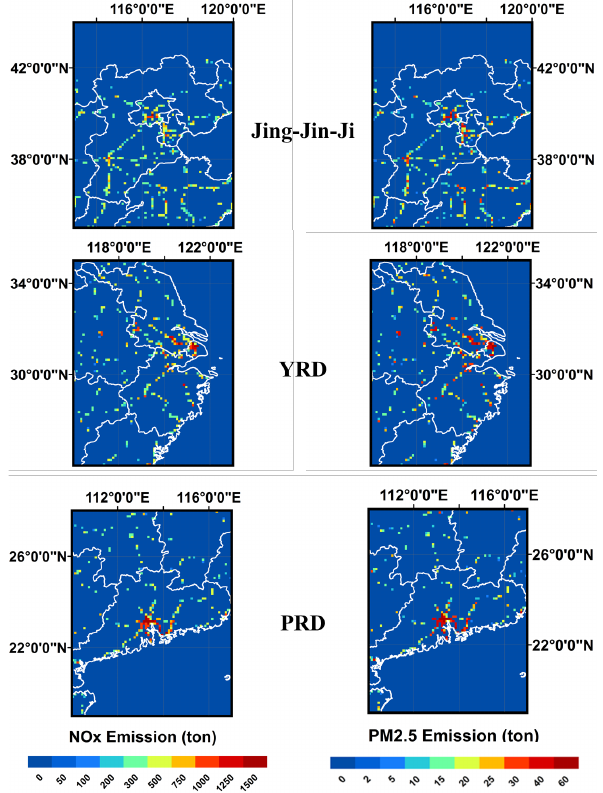
Figure 9. Maps of NO x and PM 2 . 5 emissions from freight trucks in the eastern part of China in